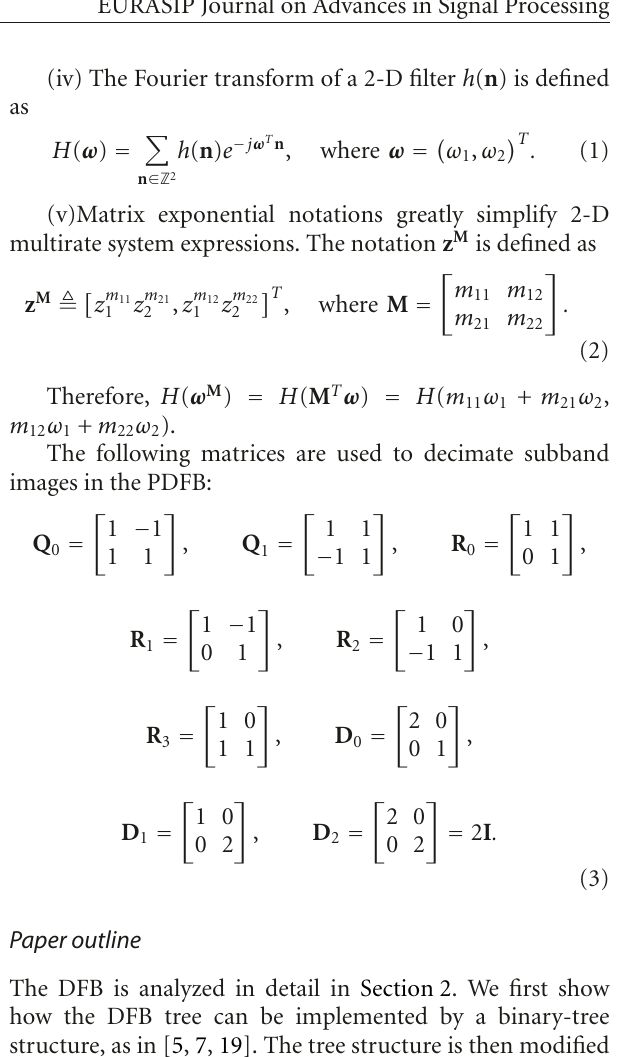
algorithm outperforms the current state-of-the-art wavelet-